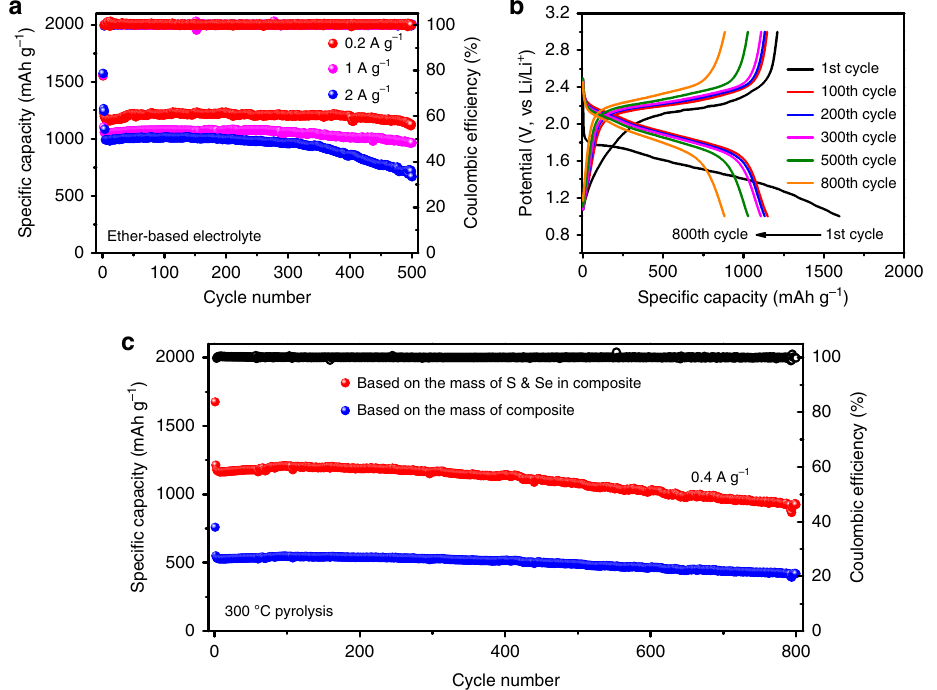
Fig. 4 Electrochemical performance of the lithium – sulfur batteries. a Cycle performance of Se 0.06 SPAN at various current densities in ether-based electrolyte. b Electrochemical discharge and charge pro fi les of Se 0.06 SPAN at various cycles. The tests are performed at 0.4 A g − 1 . c Capacity and Coulombic ef fi ciencies versus cycle number for Se 0.06 SPAN. The red curve report capacities relative to the weight of the S and Se in the cathode, whereas the data represented by blue curve are the corresponding capacities based on the overall composite mass